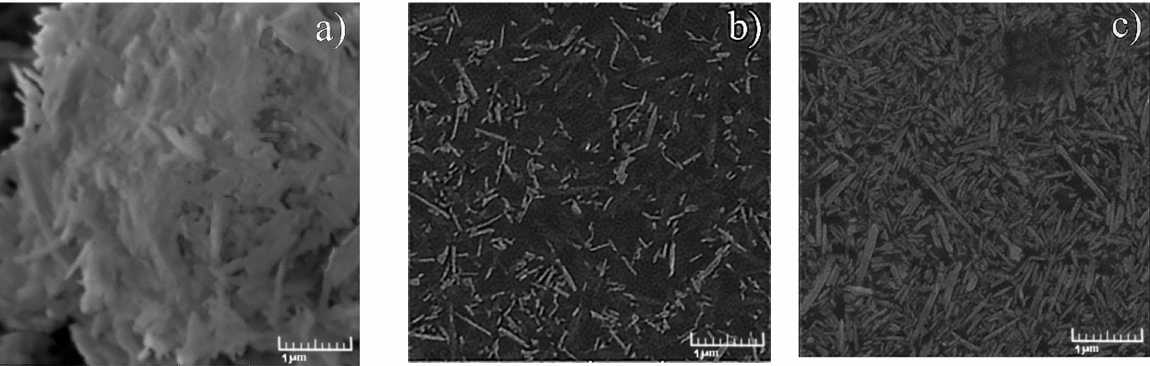
Figure 1. SEM image of Hal ( a ), BMImAc/Hal ionogel ( b ) and BMImAc/Hal/MCC-4 ionogel ( c ).